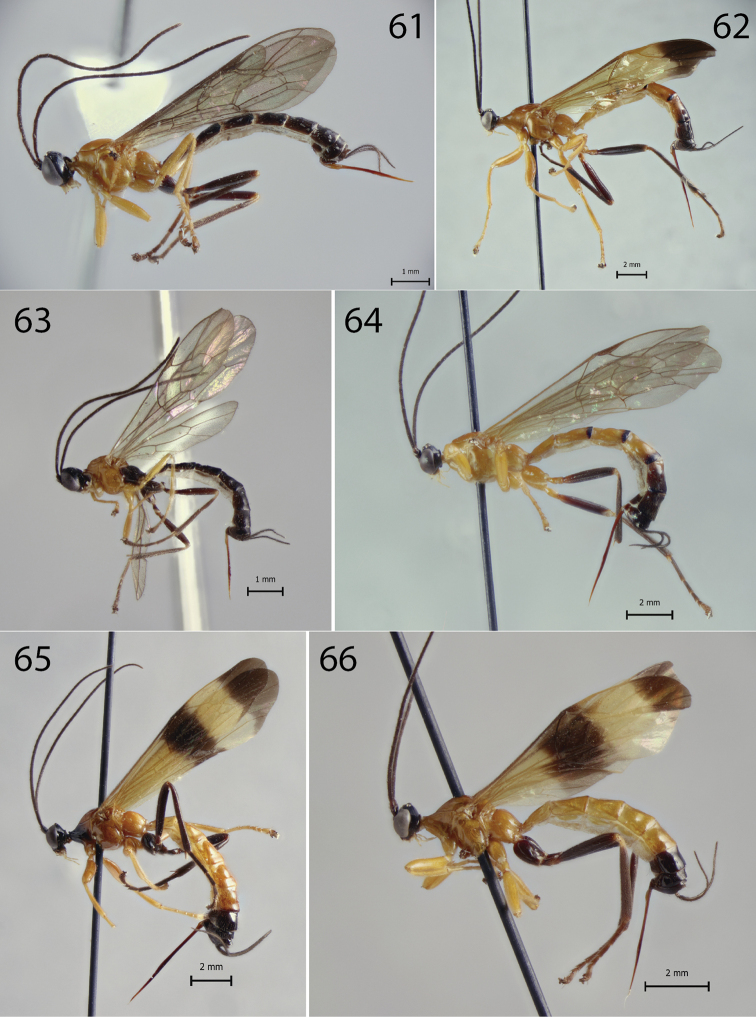
Habitus of Hymenoepimecis spp. (females), lateral view 61H.
andina sp. nov. (holotype) 62, H.
bicolor63H.
castilloi sp. nov. (holotype) 64H.
dolichocarinata sp. nov. (holotype) 65H.
duckensis66H.
ecuatoriana sp. nov. (holotype).